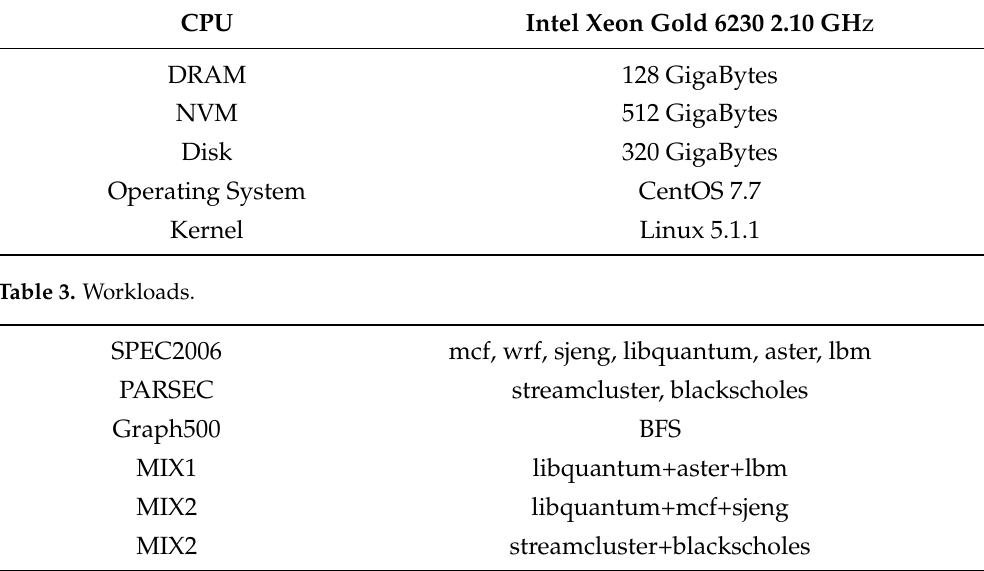
Table 2. Configurations of our hybrid memory system.